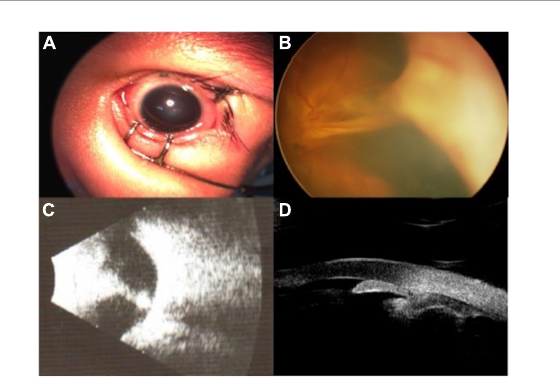
FIGURE2 The preoperative external and fundus photograph, ultrasound, and UBM of typical patients. An external photograph showed corneal edema (A) . Fundus image showed extensive funnel-like retinal detachment (B) . Ocular ultrasound showed retinal detachment (C) . UBM showed the disappearance of the anterior chamber (D)